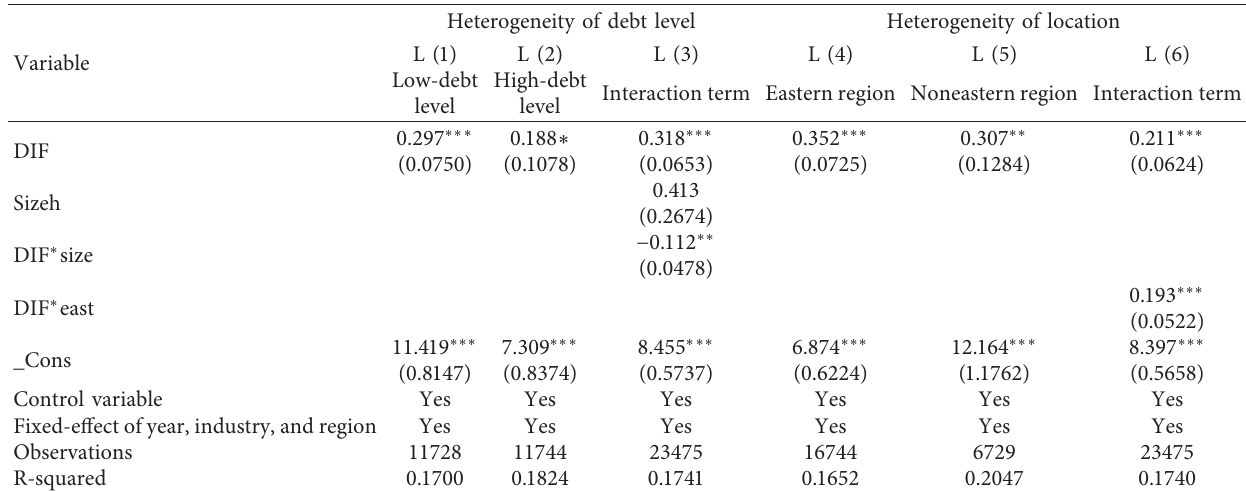
Table 6: Heterogeneity